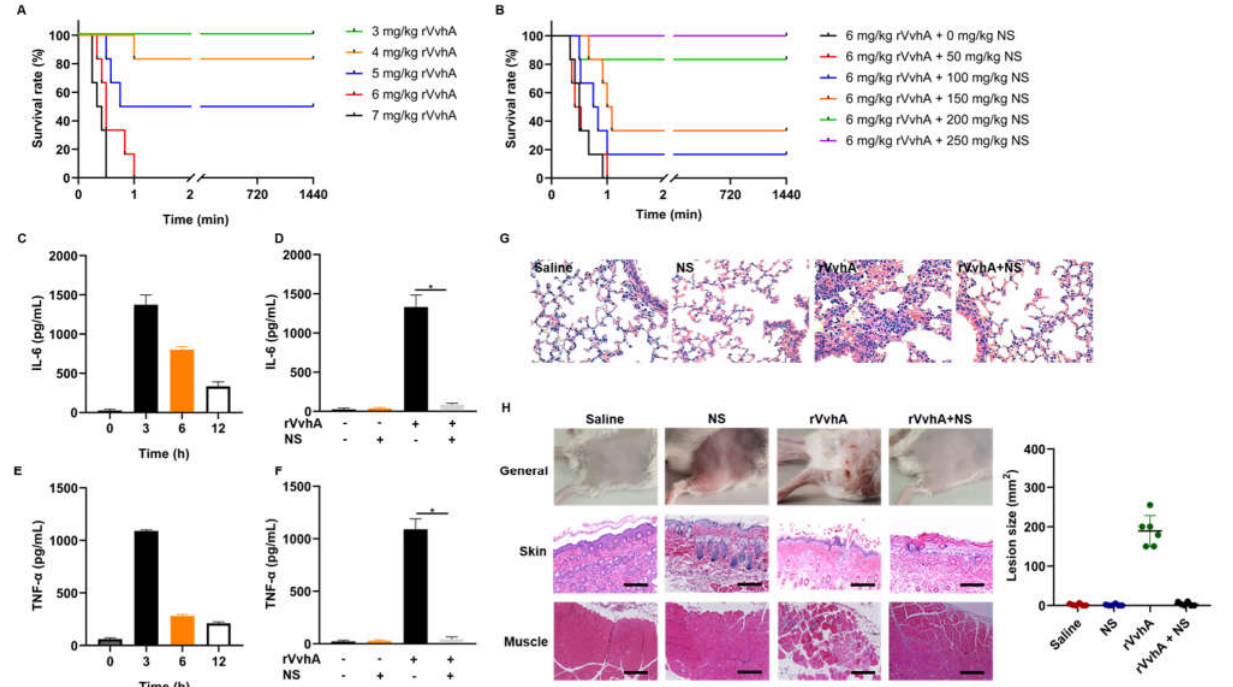
Figure 5. Protective effects of NSs in vivo. ( A ) Different doses of rVvhA (3, 4, 5, 6, 7 mg/kg) were injected intravenously, and mouse mortality was recorded. ( B ) A lethal dose of rVvhA (6 mg/kg) was injected via the tail vein, and different doses of NSs (0, 50, 100, 150, 200, 250 mg/kg) were immediately administered for treatment. ( C , E ) Mice were exposed to sublethal doses of rVvhA (3.7 mg/kg), and inflammatory factors, including IL-6 and TNF-α, were examined at predetermined times (0, 3, 6, 12 h). ( D , F ) NSs (200 mg/kg) were used to neutralize rVvhA (3.7 mg/kg) for 3 h in vivo, and then IL-6 and TNF-α in the blood were measured. ( G ) rVvhA (3.7 mg/kg) was used to stimulate mice for 3 h with or without NSs (200 mg/kg), and the lungs were harvested for hematoxylin and eosin (H&E) staining and pathological observations. Untreated mice and mice injected with NSs were used as controls. (Original magnification × 400) ( H ) rVvhA (30 μg) was injected subcutane- ously to imitate local infections, and NSs (50 mg/kg) were used for treatment. After 3 d, the injection sites were measured and photographed, and then the topical skin and muscle tissues were harvested for H&E staining and pathological observations. (Scale bar: 50 μm. The data represent the means ± SE. n = 6. * p < 0.05) .